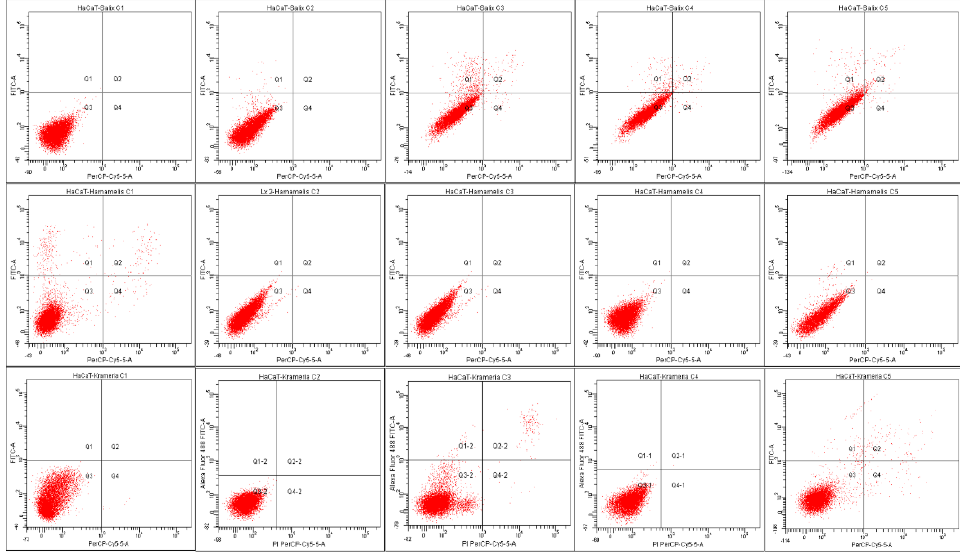
Figure 2. Apoptosis evaluation in HaCaT cells after treatment with hydroalcoholic extracts ( H. virginiana , S. alba , K. lappacea ). After 24 h of treatment, cells were stained with annexin V-FITC (50 µg/mL) and propidium iodide (100 µg/mL) and were evaluated with a BD FACS Canto II flow cytometer (Becton Dickinson, Franklin Lakes, New Jersey, USA), by using BD FACS Diva 6.1.2 software. The results are presented in scatter plots of annexin V-fluorescein isothiocyanate versus vital dye propidium iodide labelling Q3, viable cells; (annexin V-FITC ( − ), PI ( − )); Q1, early apoptotic cells (annexin V-FITC (+), PI ( − )), Q2, late apoptotic (annexin V-FITC (+), PI (+)); and Q4—necrotic cells (annexin V-FITC ( − ), PI